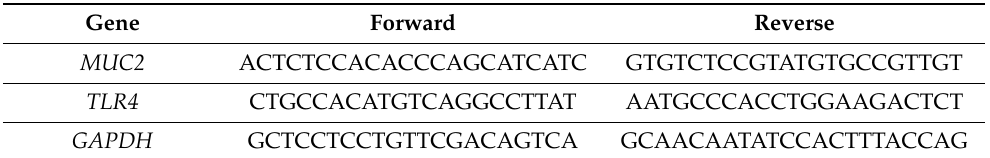
Table 1 (5 (cid:48) to 3 (cid:48) ): Table 1. The primers used for Quantitative PCR of MUC2 and TLR4.